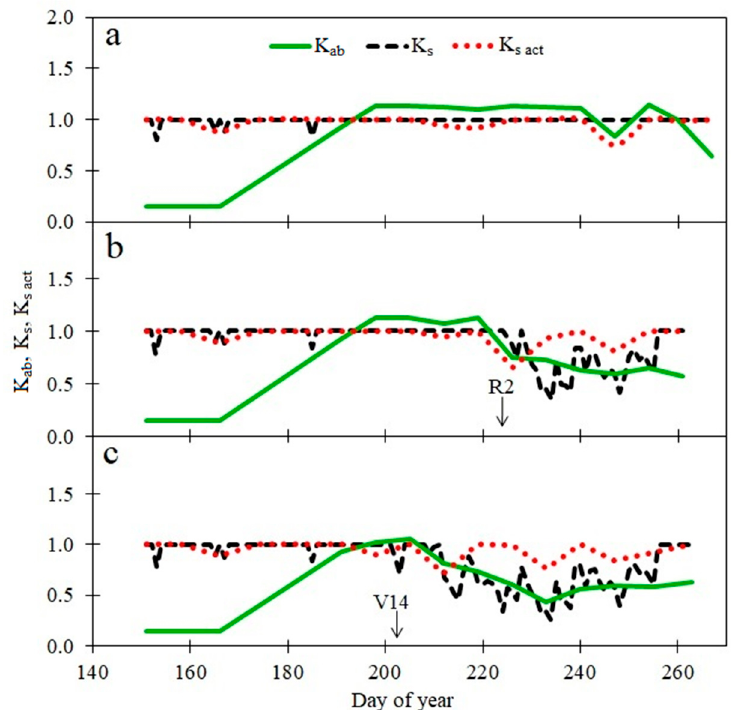
Figure 2. Actual basal crop coefficient (K ab ), estimated water stress coefficient (K s ) according to Allen et al. [22], and the field-based calculated water stress coefficient (K s act ) of maize by day of year when there was no drought stress ( a ), drought stress from the blister maize phenological stage (R2) to maize physiological maturity (R6) ( b ), and drought stress from the 14 leaf collar maize phenological stage (V14) to R6 ( c ), across hybrids for the experiment where maize followed soybean and received the optimal nitrogen rate.